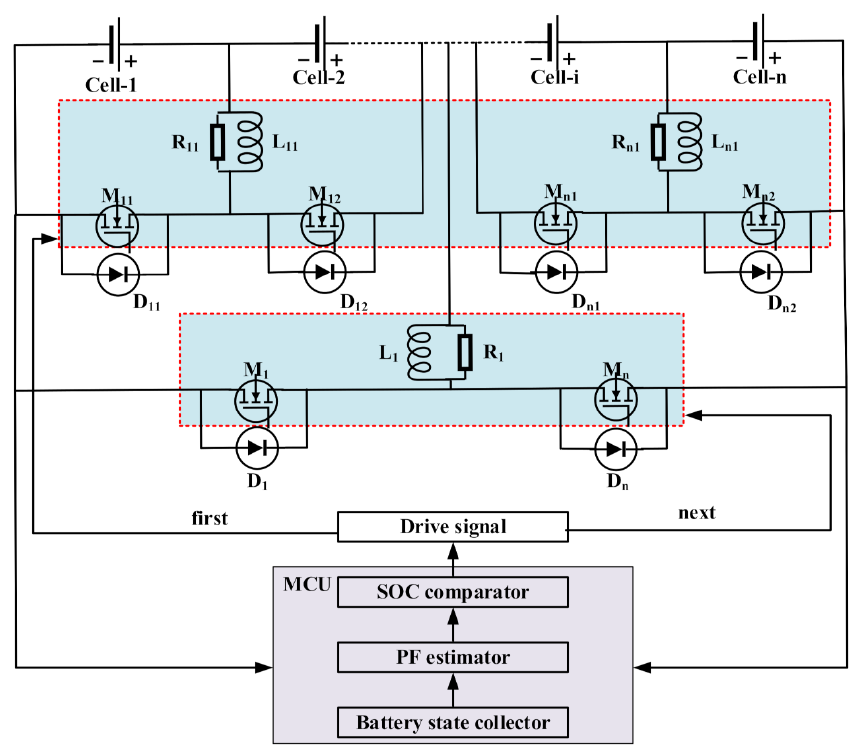
Figure 1. Double-layer inductance balance circuit